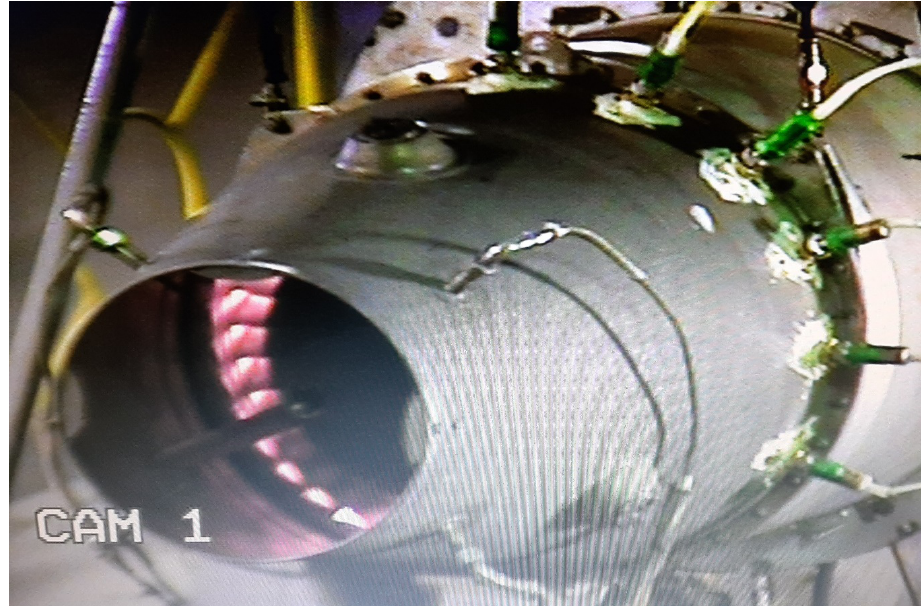
Figure 12. Sensors operated in a SO-3